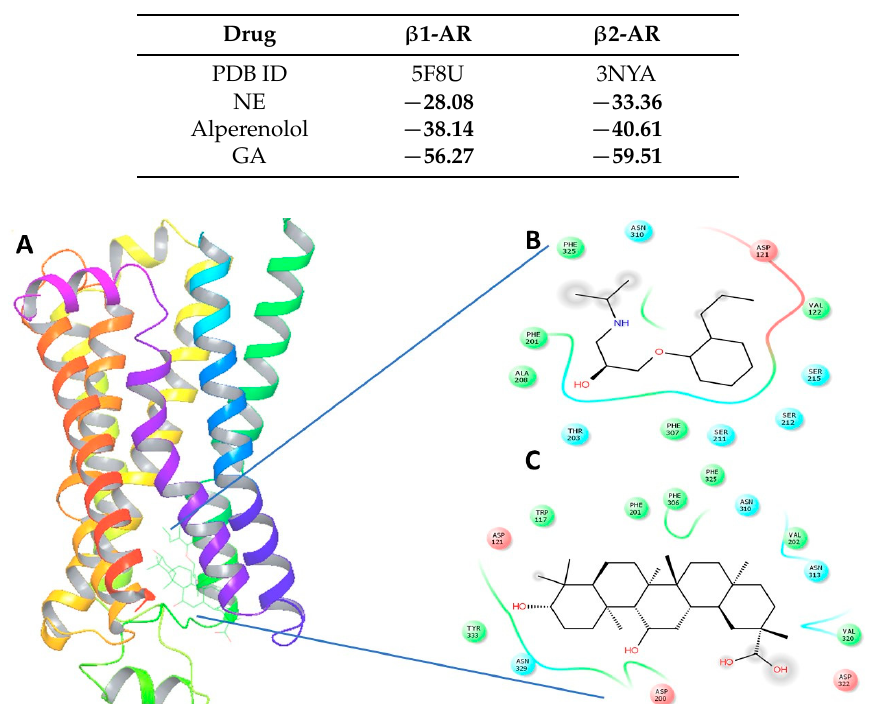
Figure 4. ( A ) The 3-Dimensional image of β 1-AR docked with GA and alperenolol signifying same binding region for both drug molecules; ( B ) 2-Dimensional image of the interacting amino acid residues with alperenolol; ( C ) 2-Dimensional image of the interacting amino acid residues with GA molecule.